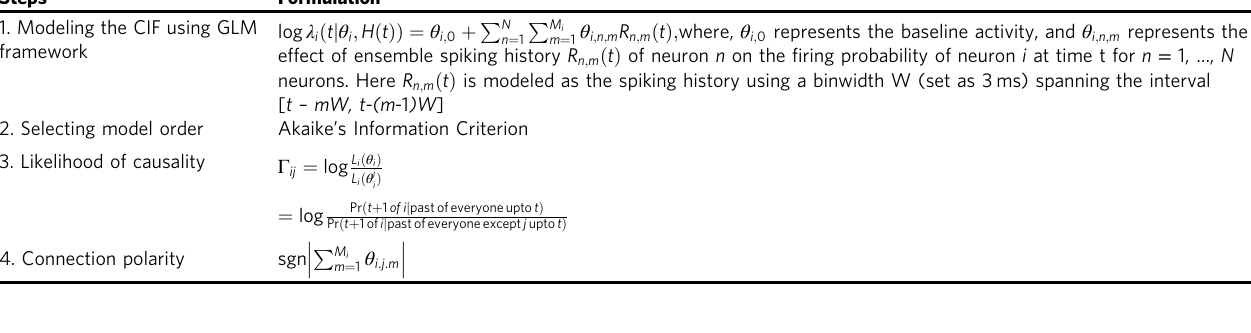
Table 1 Granger causality analysis to estimate connectivity Steps Formulation